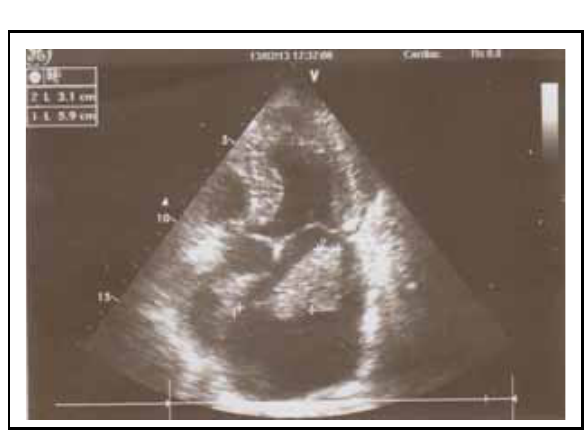
Figure 2. Echocardiographic view of larger end of tumor in right